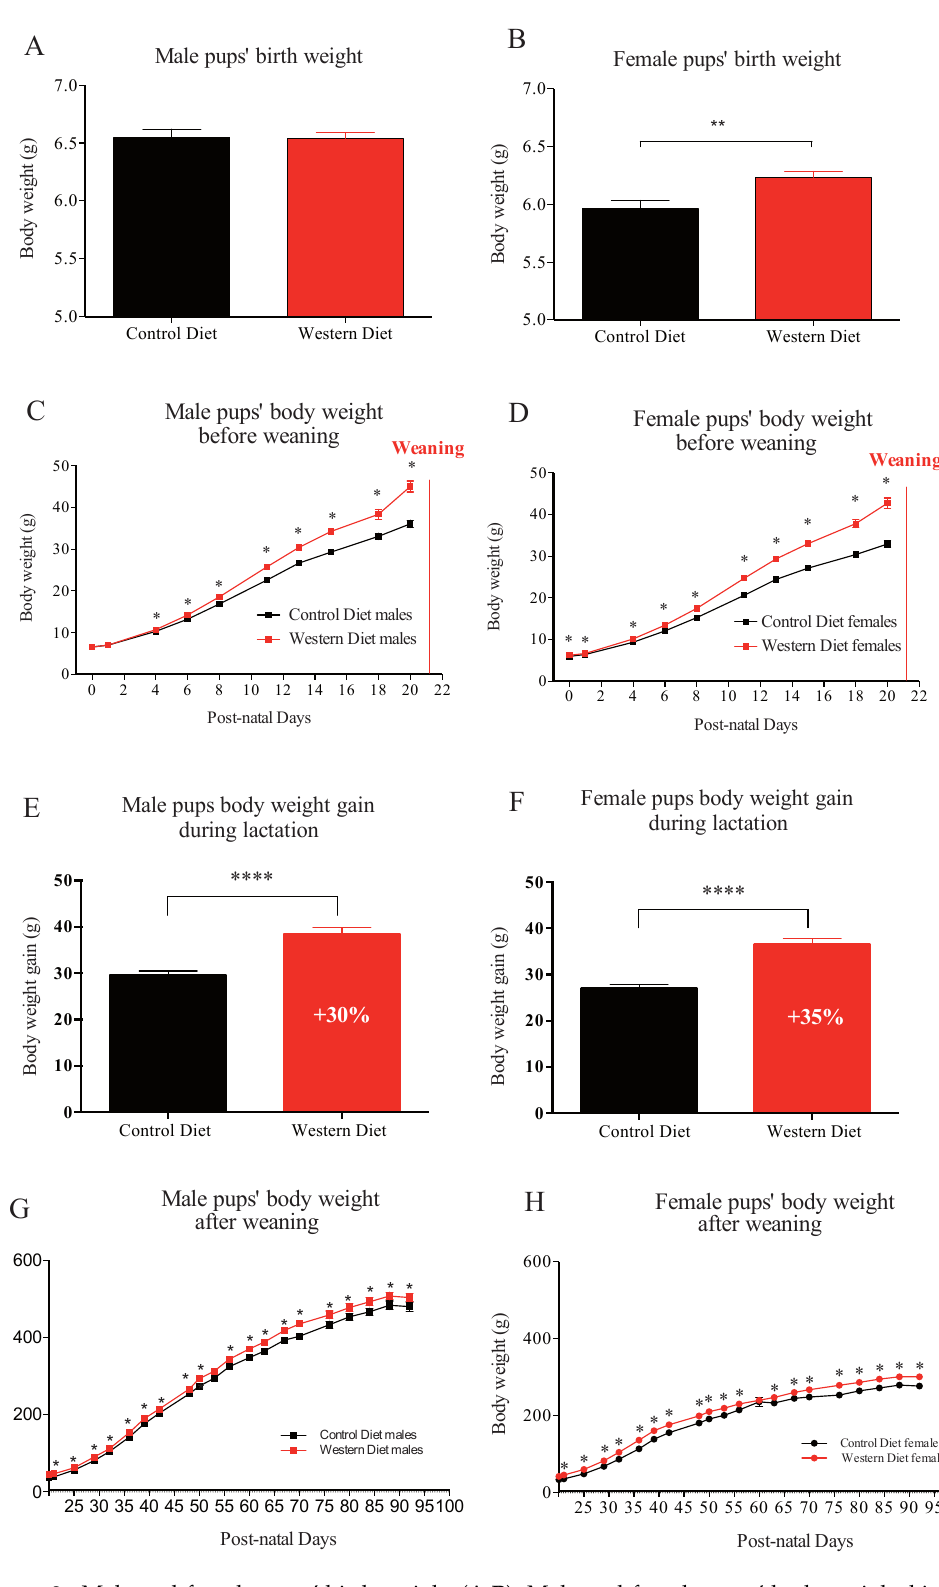
Figure 2. Male and female pups’ birth weight ( A , B ), Male and female pups’ body weight